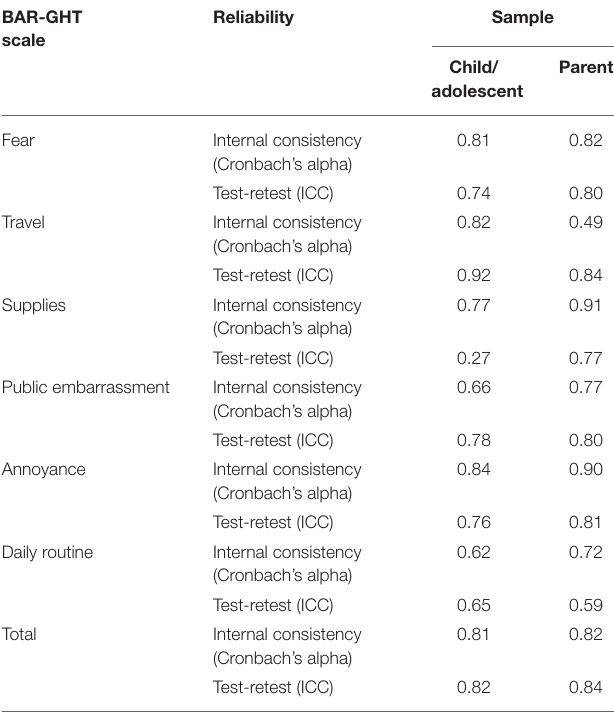
TABLE 4 | Internal consistency and test-retest reliability of the BAR-GHT